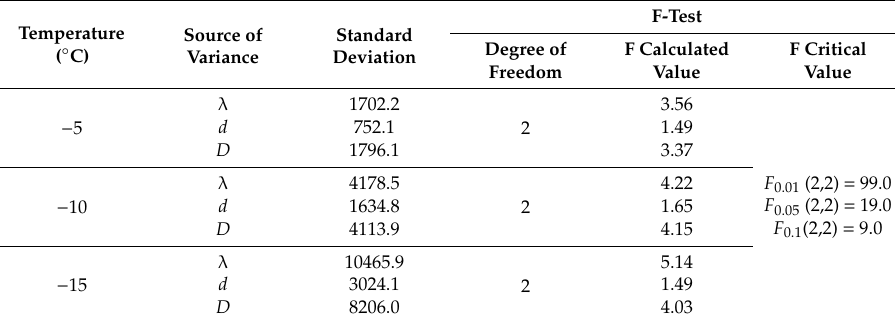
Table 8. The results of variance analysis and